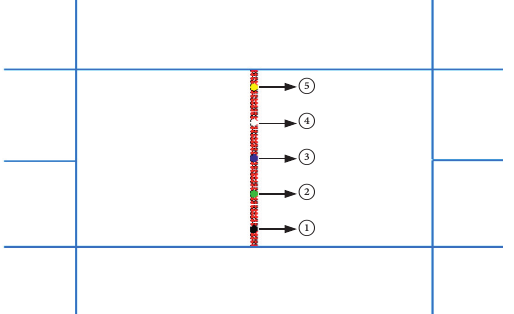
Figure 10: Position of measurement cycle.